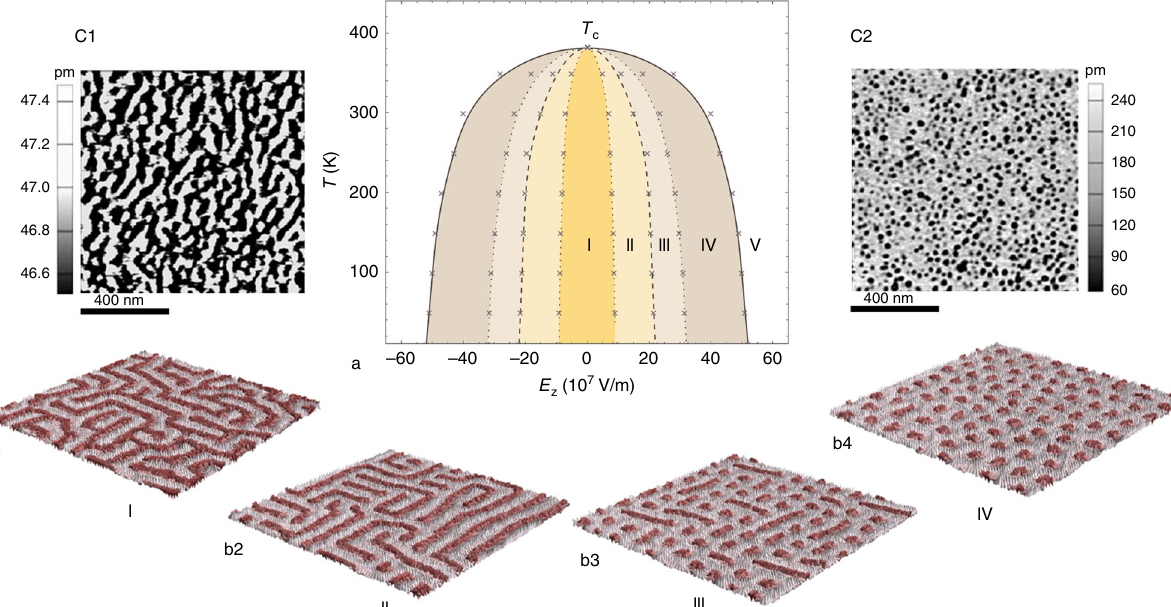
Fig. 2 Nonequilibrium phase diagram of compressively strained low-dimensional PZT ferroelectric. a Temperature-electric fi eld phase diagram of a Pb (Zr 0.4 Ti 0.6 )O 3 ultra-thin fi lm mimicked by a 80 × 80 × 5 supercell. Crosses correspond to transition fi eld values calculated through the zeroth Betti number (see Supplementary information) and lines interpolate between the data points obtained for 10 K and from 50 K to 350 K by steps of 50 K. Phases I and II correspond to connected and disconnected labyrinthine patterns, respectively, while phases III and IV denote the mixed bimerons-skyrmion phase and the skyrmions (or bubble) phase, respectively. Phase V corresponds to states where all dipoles are aligned along the applied fi eld. The dashed line separating phases II from III marks the spinodal-like boundary, while the solid line separating phases IV from V marks the binodal-like boundary. b 1 – b 4 provide dipolar con fi gurations as obtained from simulations within each of phases I – IV in the middle layer of the 80 × 80 × 5 fi lm at 10 K, where gray (red) dipoles are oriented along [001] ([00 (cid:1) 1]) pseudo-cubic direction. c 1, c 2 show experimental PFM amplitude images of PZT fi lms with 1 unit cells STO spacer and reveal labyrinthine and bubble-skyrmion morphologies, respectively. The labyrinth domain pattern was obtained after annealing the as-grown PZT fi lms at 525 K for 10 min in air, and cooling it down to room temperature at cooling rate of 10 – 15 K/min. The bubble domains were then created by scanning the labyrinth domains using a SPM probe with an AC amplitude of 500